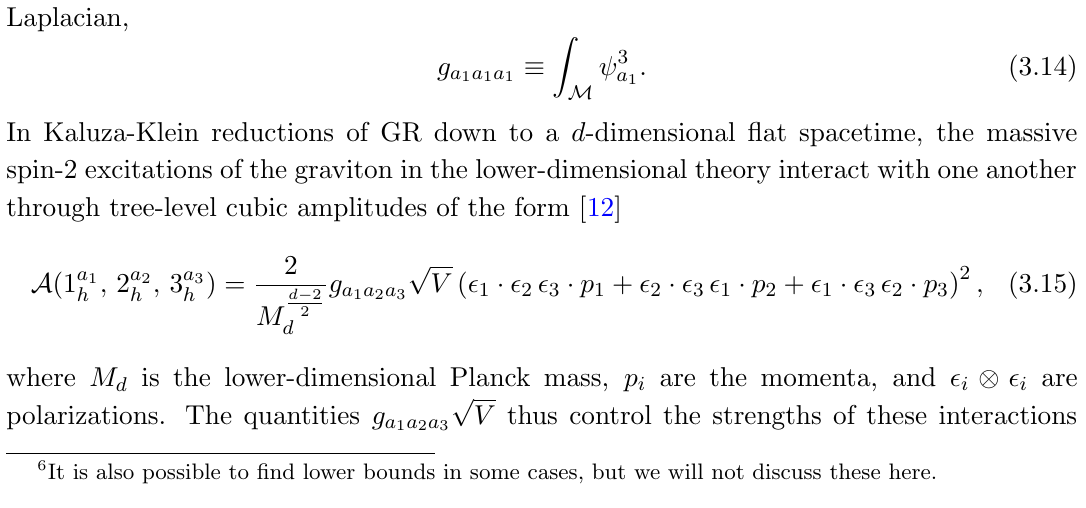
Figure 6 . Upper bounds on the ratio of any two consecutive nonzero eigenvalues of the scalar Laplacian for closed Einstein manifolds with R (cid:21) 0 and N = 2 ; : : : ; 8 for di(cid:11)erent values of (cid:21) I The bounds for (cid:21) I (cid:21) 0, given by the solid black line, are the same for each N 1